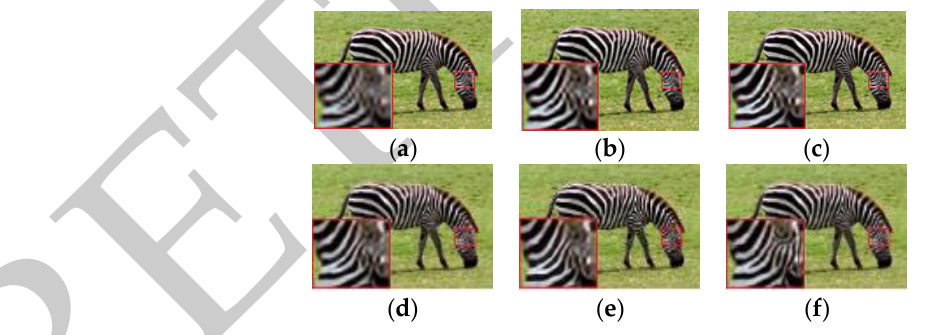
Figure 6. Super- resolution reconstruction results of the image “ Zebra ” with “ ×3 ” scale factor . ( a ) Figure 6. Super-resolution reconstruction results of the image “Zebra” with “ × 3” scale Bicubic [5]; ( b ) A+ [11]; ( c ) SRCNN [18]; ( d ) EEDS [20]; ( e ) The Proposed Method; ( f ) Original Image.